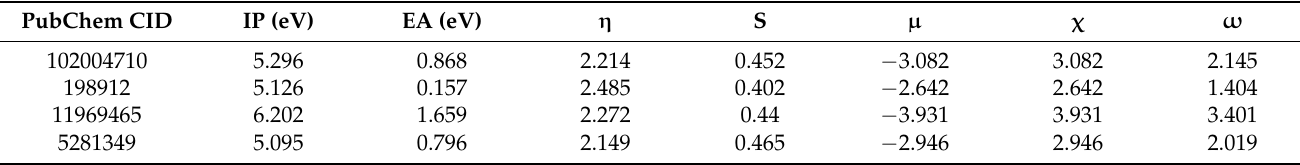
Table 6. Estimated ionization potential (IP), electronic affinity (EA), global hardness ( η ), global softness (S), chemical potential ( µ ), electronegativity ( χ ), and the electrophilicity index ( ω ) energy of the four optimized selected molecular